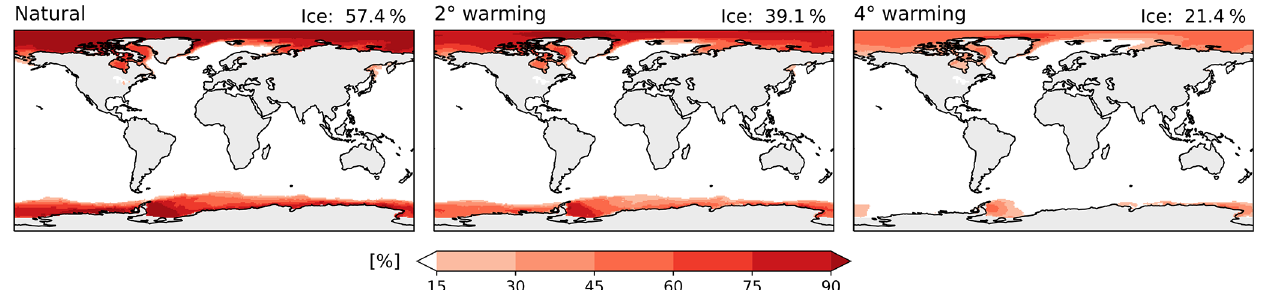
Figure A2. Absolute sea ice coverage fractions for 2018 in the natural, warming20 and warming40 simulation determined with the algorithm presented in this study. The numbers in the upper right corner indicate the yearly average sea ice coverage fraction for ice grid cells.